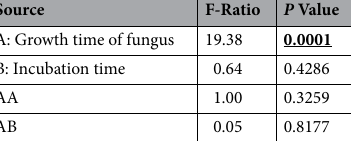
Table 4. Analysis of variance for the variable area under the curve. Effect growth time of fungus in the synthesis of